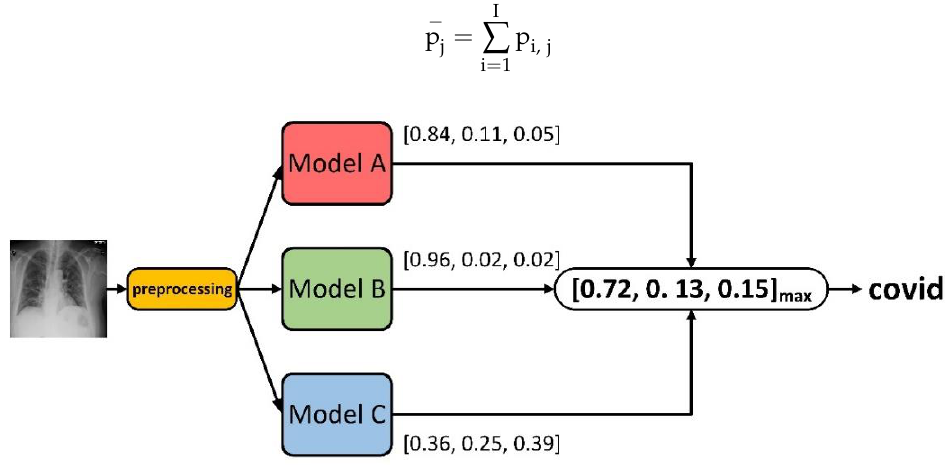
Figure 4. Schematic diagram of confidence fusion.